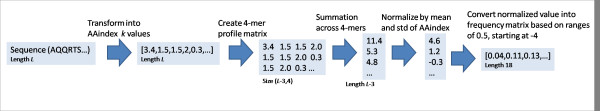
Schematic of the process of feature generation for a single sequence.